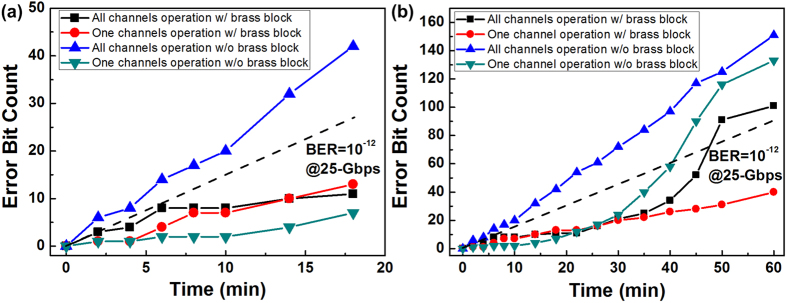
Error bit counts measurements of the 100-Gbps optical transceiver with and without brass block based metal heatsink.(a) Error bit counts within 18 minutes for the optical transceiver with and without brass block; (b) Error bit counts within an hour for the optical transceiver with and without brass block.